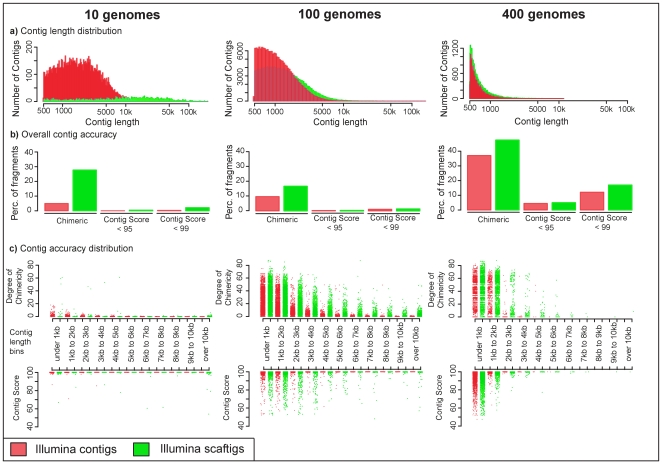
Comparison of assemblies of Illumina contigs and Illumina scaftigs.Scaffolds are constructed by linking contigs using information from paired end reads, during this process a number of unknown bases are usually found between the sequences of the linked contigs. To use the information obtained by scaffolding, Scaftigs can be constructed by extracting the contiguous sequences that lack unknown bases (Ns). a) Contig Length Distribution. Histograms of the contig lengths illustrate the number of contigs within a certain size fraction for assemblies of Illumina contigs (red) and Illumina scaftigs (light blue). Only contigs greater than 500 bp are shown, the x-axis is log scale. Assemblies were generated for different community complexities (10 genomes, 100 genomes, 400 genomes). b) Overall Accuracy of the Contigs. The overall accuracy of the contigs is summarized using different measures of chimericity. Bars to the left illustrate the percentage of all of the contigs that are chimeric, bars in the middle show the percentage of all of the contigs that have a Contig Score less than 95%, and to the right contigs that have a Contig Score less than 99%. Contig Score represents the percent identity between the contig and the derived reference genome. Illumina contigs are in red Illumina scaftigs are blue. c) Contig Accuracy across Contig Lengths. These combined strip plots show the degree of chimericity (upper plot) and contig score (lower plot) for each contig in the assemblies, each dot represents one contig. They are grouped into size bins. The degree of chimericity is the proportion of reads in a contig that are derived from the ‘wrong’ genome and thus make the contig chimeric. Contig Score represents the percent identity between the contig and the derived reference genome. Again Illumina contigs are in red and Illumina scaftigs are in blue.